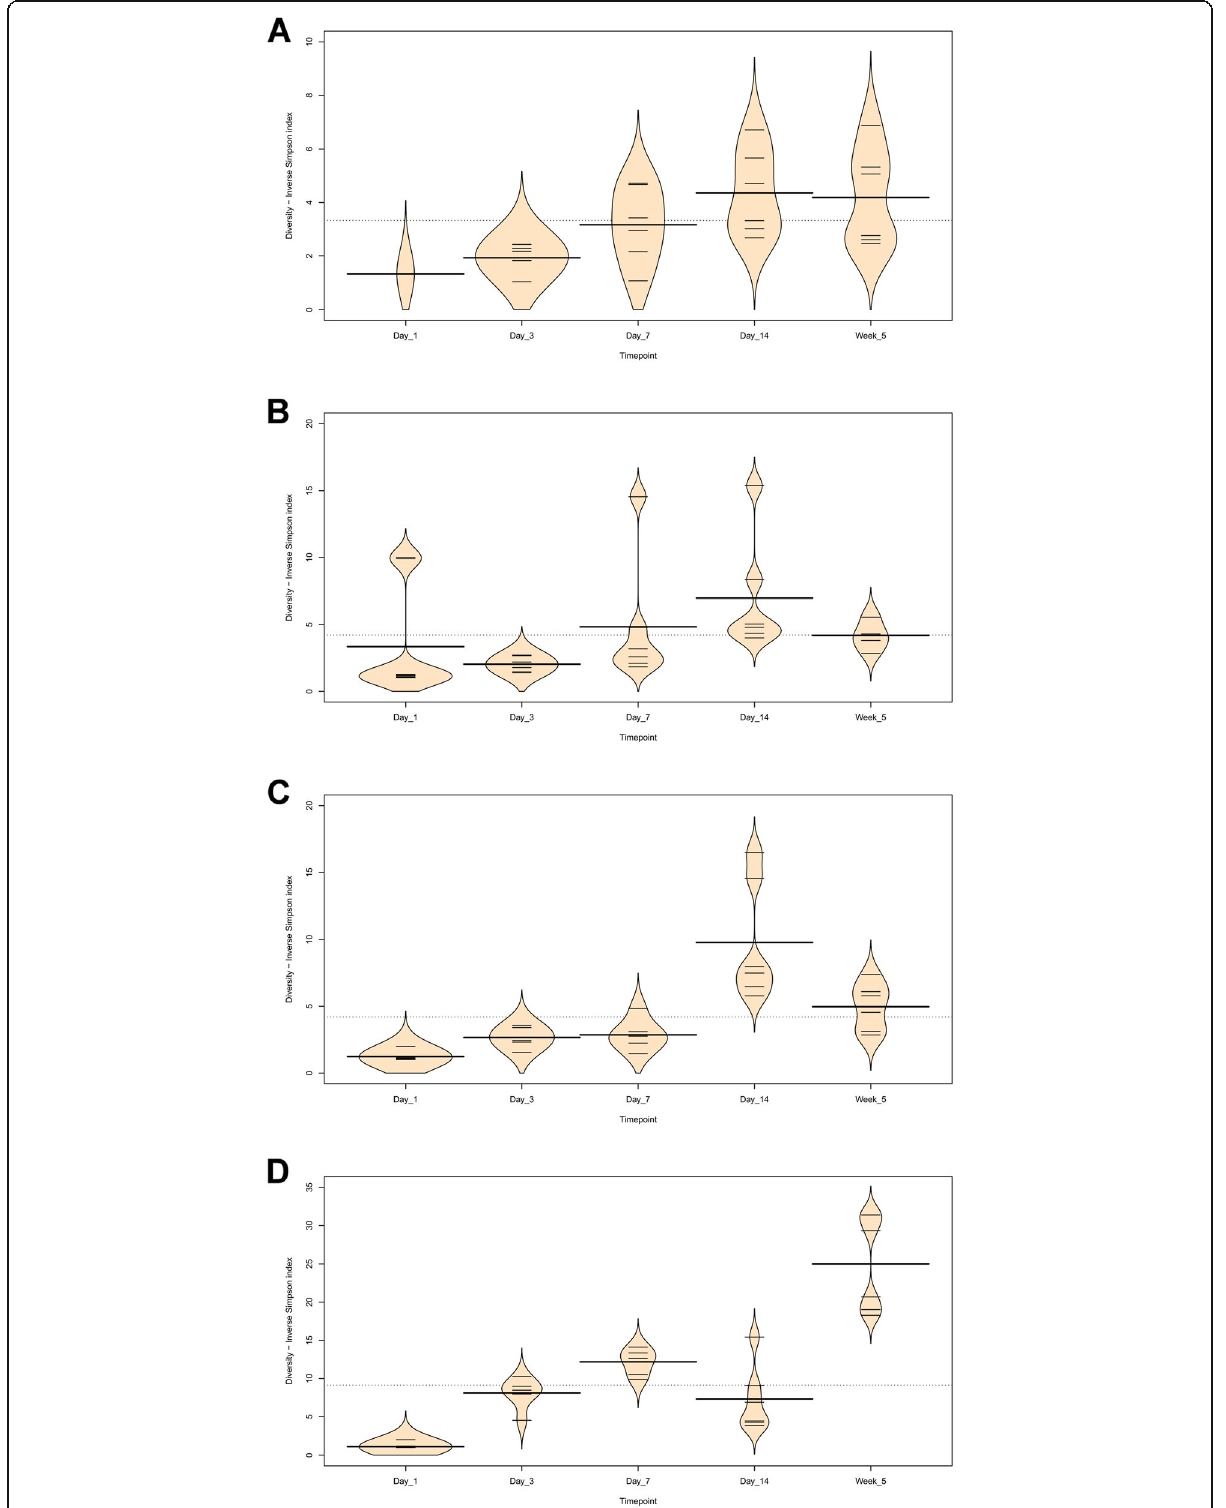
Fig. 4 Beanplots showing diversity (Inverse Simpson Index) of chicken intestinal microbiota communities across timepoints (subsampled to 10,000 reads). Small bars represent individual data points while the wider line within each timepoint represents the mean. a ) Duodenum b ) Jejunum c ) Ileum d )